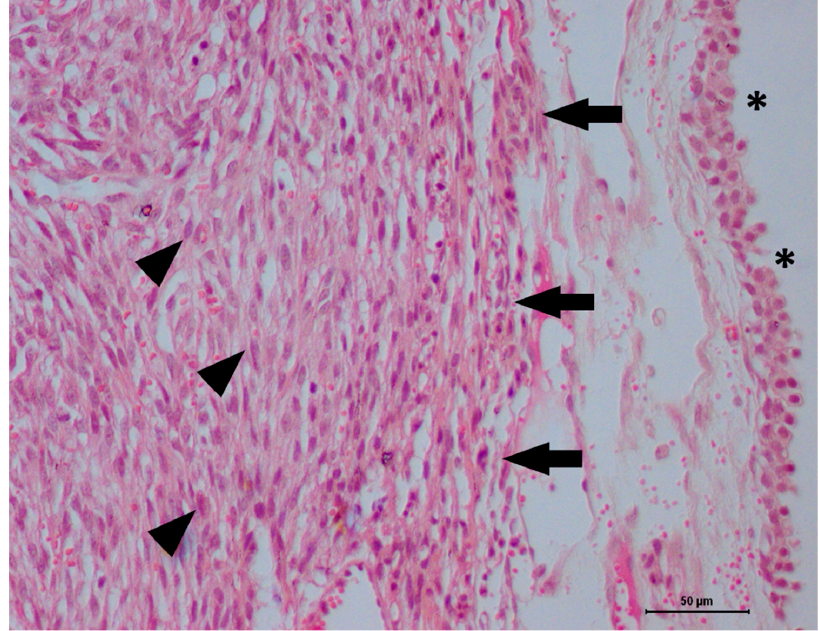
Figure 3. High-power magnification view of a feline bladder leiomyosarcoma. A normal urothelial cell in the bladder mucosa (asterisk), and a mesenchymal tumor in the bladder submucosa (black arrows) can be observed. The tumor cells exhibit a fusiform shape, with moderate anisokaryosis (arrowhead), and discrete hemorrhagic areas. Hematoxylin and eosin staining, original magnification 40×.